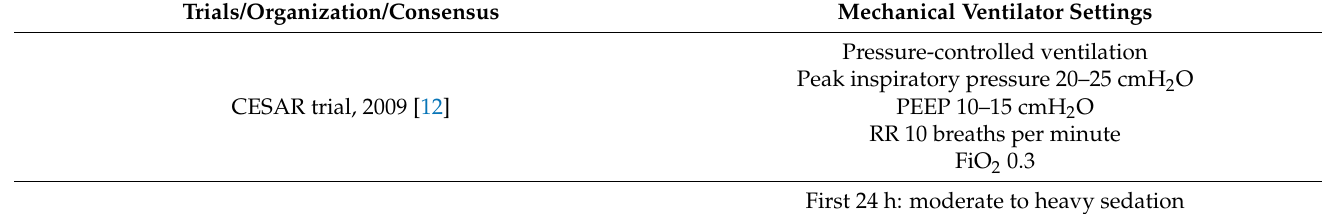
Table 2. Initial mechanical ventilation settings during ECMO for patients with ARDS in clinical trials, organization, or a consensus of expert opinions.